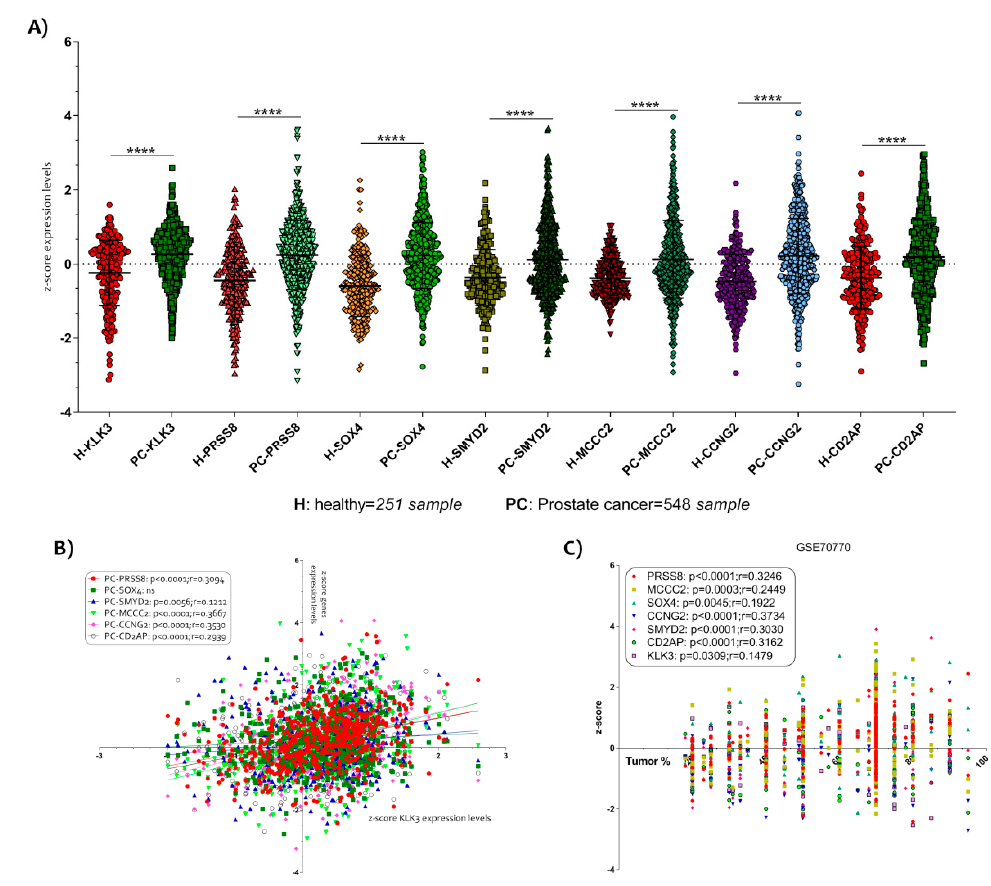
Figure 3. Selection of six key genes modulated in PCa. ( A ) In order to allow the comparison of microarray datasets independent of the original hybridization intensities, we decided to apply a Z score transformation. The normalization allowed us to applicate a Z test for the six genes most significantly up-regulated in PCa and down-regulated by the action of Vitamin D in the LNCaP cell line. We obtained 251 healthy subjects and 548 PCa samples. All genes selected (KLK3, PRSS8, SOX4, SMYD2, MCCC2, CCNG2 and CD2AP) resulted significantly up-regulated in PCa biopsies compared to prostate biopsies of healthy subject ( p < 0.0001) ( B ). A significantly positive correlation was observed between all six key genes selected and KLK3 expression levels. ( C ) Similar results were obtained when we analyze the correlation between the six genes’ z-score expression levels and the tumor percent. Data are expressed as z-score intensity expression levels and presented as vertical scatter dot plots. p values < 0.05 were considered to be statistically significant **** p < 0.00005).